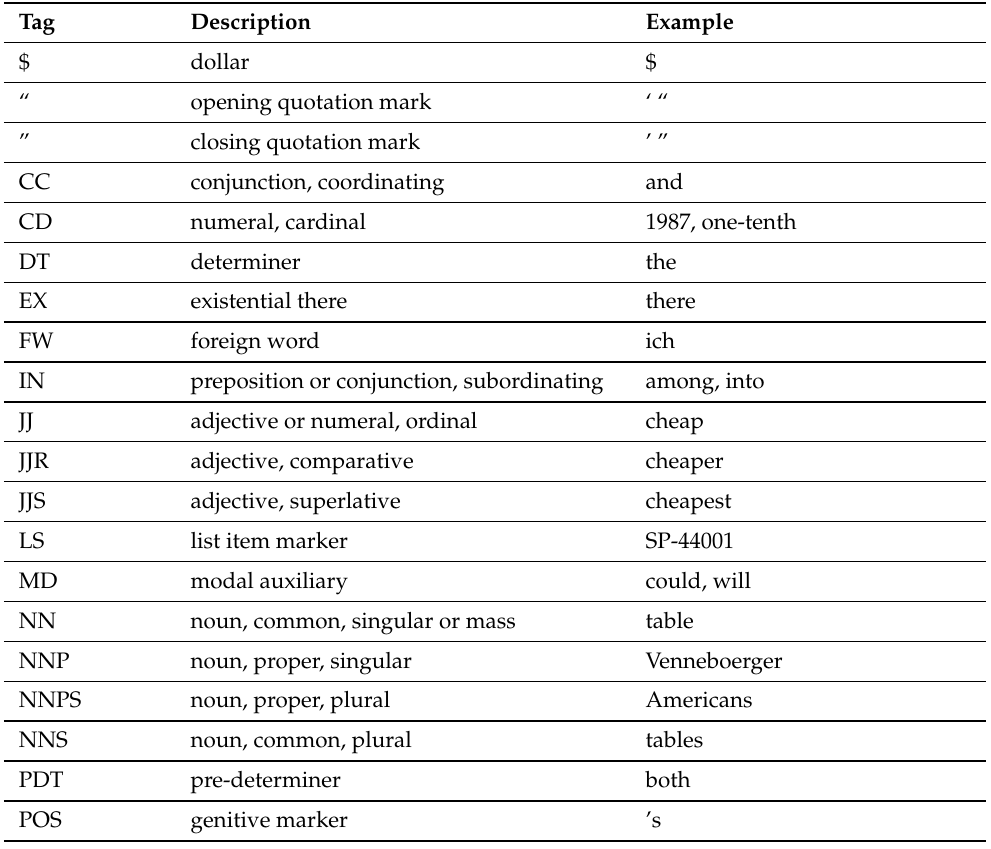
Table A1. Parts-of-speech tags included in this